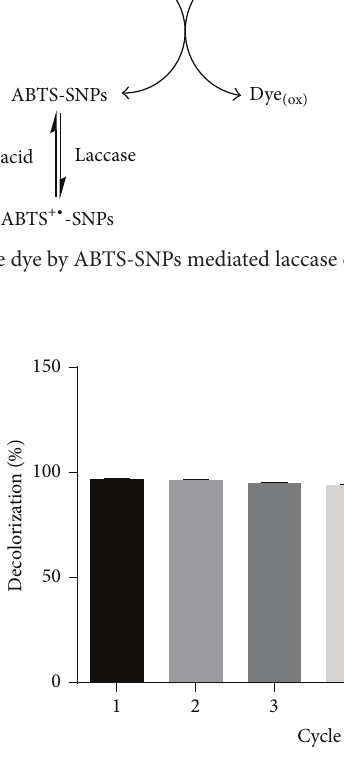
Figure 5: Reusability of ABTS-SNPs (10g/L) in six successive cycles using 3000 U/L of laccase, and 20 mg/L of indigo carmine at pH 4.5 with shaking at 150rpm for 30 min at room